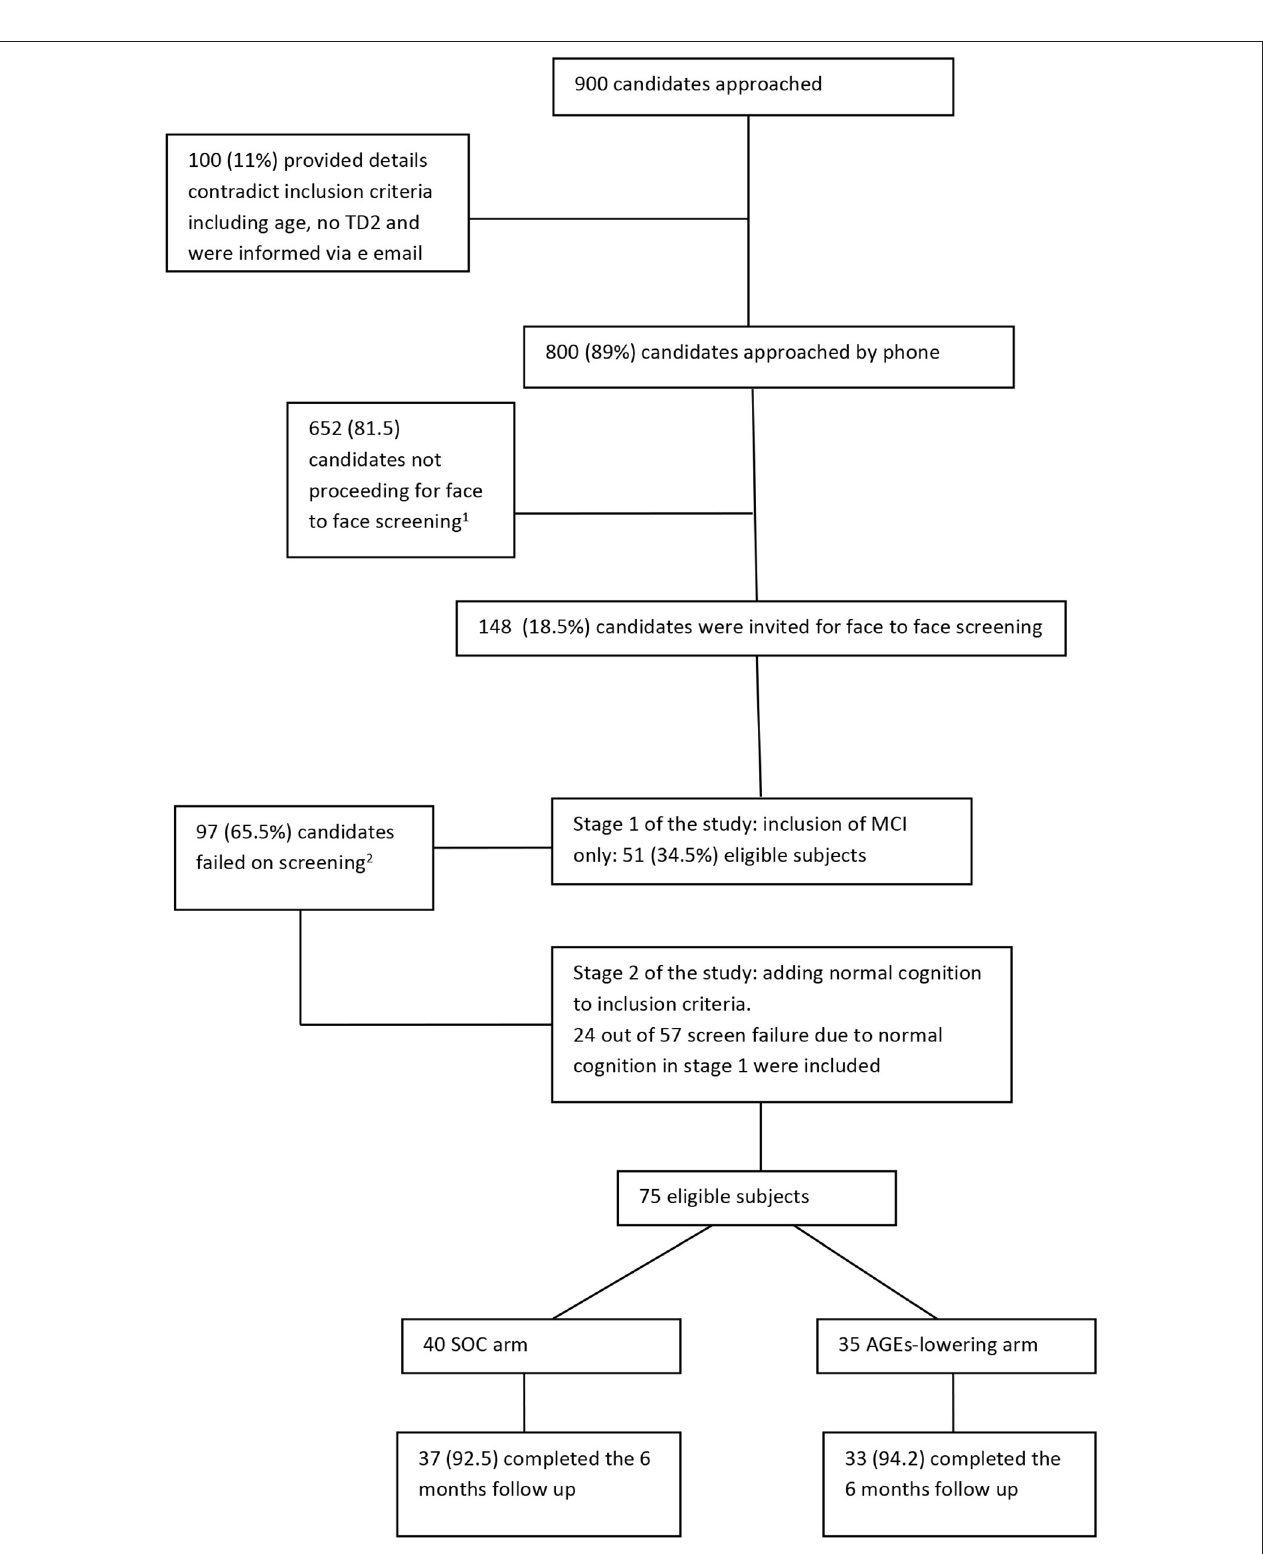
FIGURE 1 | Flow chart of study recruitment and follow-up. 1 Main reasons for not proceeding to a face to face screening were (order by prevalence): not reporting to have memory decline other than forgetting names, not having type 2 diabetes but impaired fasting glucose, no care giver available, portable issues, vegetarian,